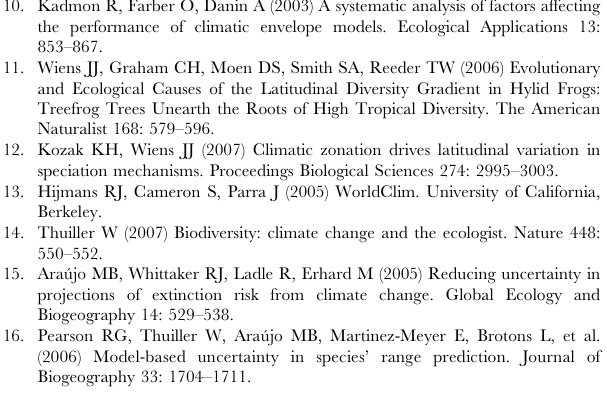
Figure S1 Degree of equilibrium of climate for amphib- ians at regional scale in the seven biogeographical regions. . 0B set of species with O equal to more or equal than 1 cell, . 10B more than 10 cells, . 15B more than 15 cells using BIOCLIM, . 15MD more than 15 using Mahalanobis, and . 15ED more than 15 using Euclidian Distance. Boxes are the percentiles from 25 to 75% around O/P medians, and lines indicate the standard deviation. (A) All orders; (B) Anura; (C) Caudata; (D) Gymnophiona. Neotropic (Neotr), Indo-Malay (Ind), Australasia (Aus), Madagascar (Mad), Afrotropic (Afr), Nearctic (Near), Palaearctic (Pale). Table S1 Descriptive statistics of the level of equilibri- um among the amphibian species at global and regional scales. Table S2 Test of the differences in the degree of climatic equilibrium between pairs of regions. The